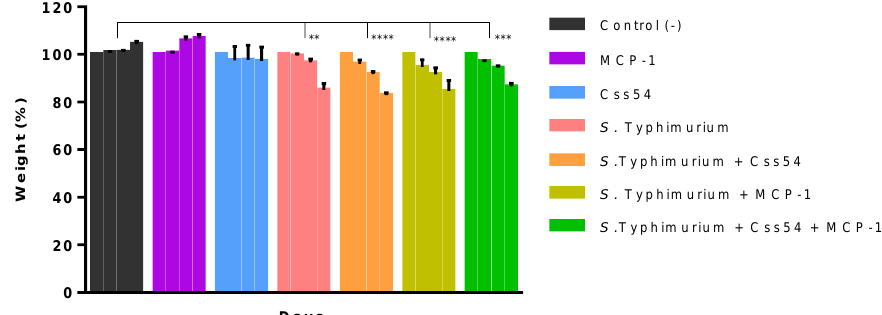
Figure 7. Weight control of mice with sepsis. Balb/C mice were infected with S . Typhimurium ( ≈ 4 × 10 6 CFU) and treated with a single dose of Css54, MCP-1, and Css54 + MCP-1 (15 µ M) at 24 h post-infection. Bars represent days 1 to 4 (72 h in total). Control ( − ): PBS ( n = 6). This figure shows the average of six individuals from two independent experiments (** p < 0.01, *** p < 0.001, **** p < 0.0001).